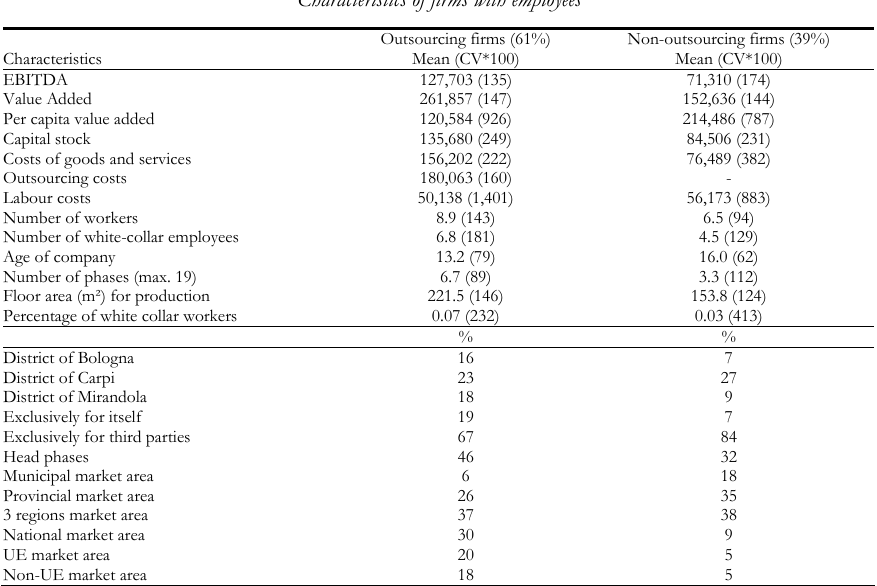
Characteristics of firms with employees Outsourcing firms